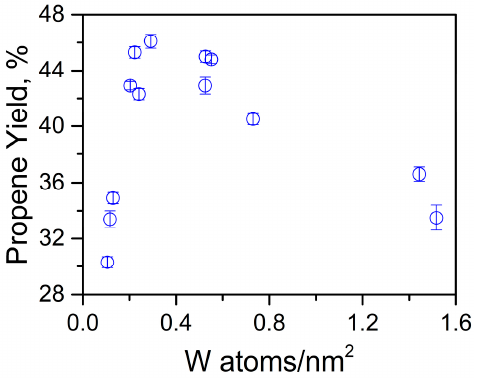
Figure 6. Comparison of propene yield with normalized W loading in various cubic mesoporous silicate supports (KIT-6, KIT-5, and SBA-16).